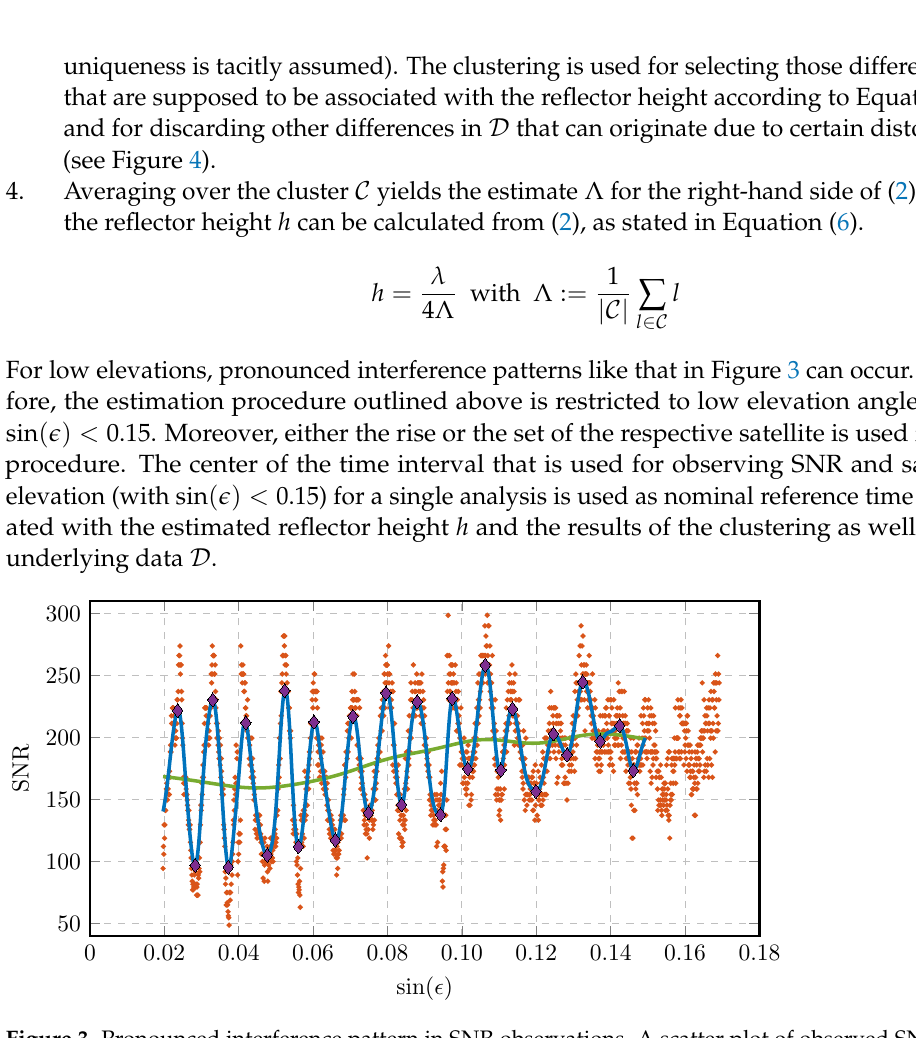
Figure 3. Pronounced interference pattern in SNR observations. A scatter plot of observed SNR data in dependence of the sine of the satellite elevation angle (cid:101) is depicted in red. A kernel regression with appropriate bandwidth resolving the regular interference pattern is shown in blue. Local extrema, as detected by the algorithm, are displayed in purple. A kernel regression with larger bandwidth is shown in green.